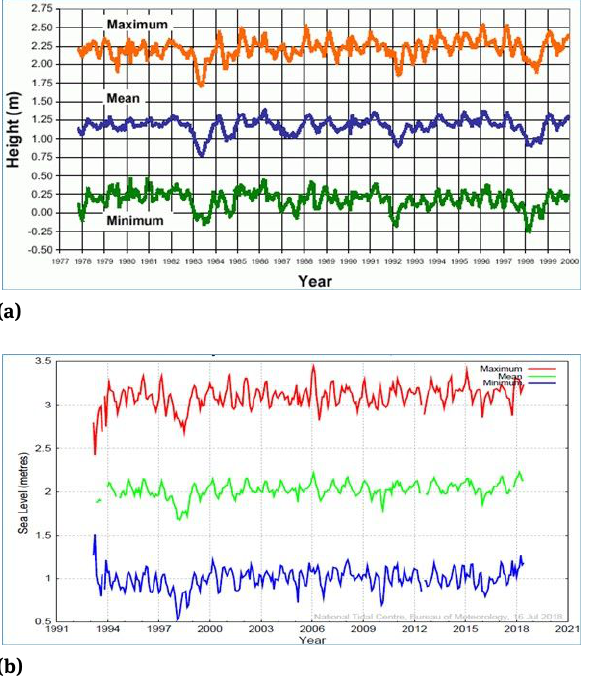
Figure 12: Monthly maximum, mean and minimum sea level in (a) FUNAFUTI, Image modified after http://www.john-daly.com/press/ press-02a.htm, and (b) FUNAFUTI B, Image modified after [51].